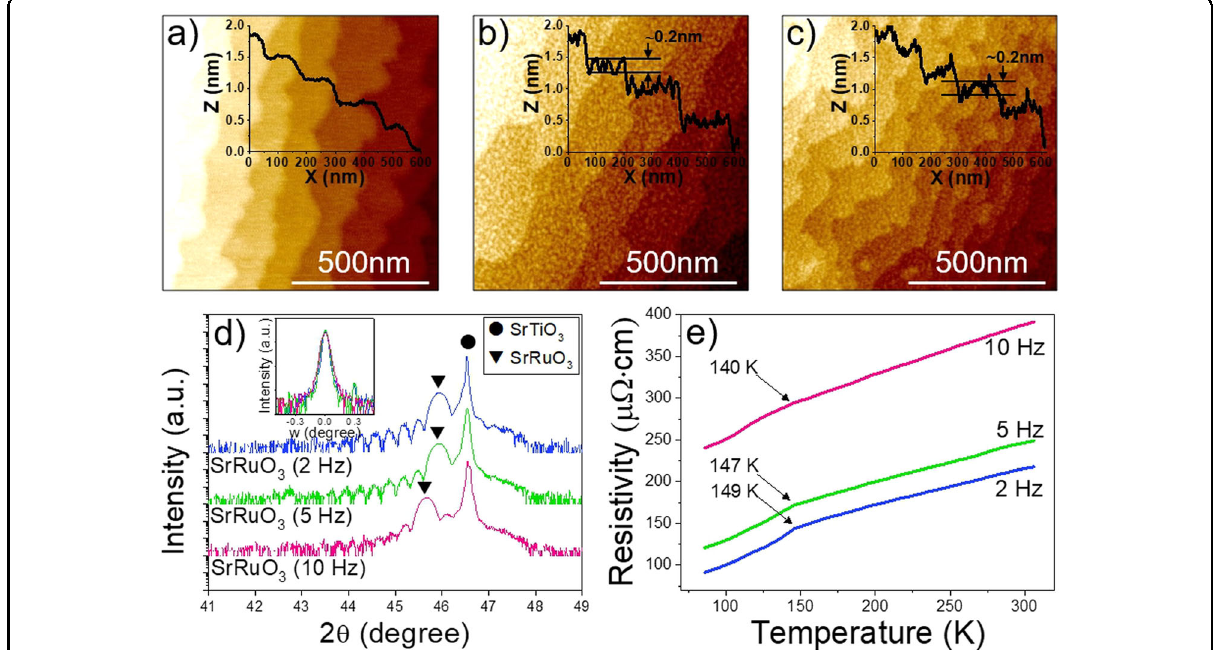
Fig. 1 Structural characterization of the SrRuO3 bottom electrodes. AFM images of SrRuO 3 electrodes grown with laser repetition frequencies of a 2, b 5, and c 10 Hz. d XRD patterns of SrRuO 3 electrodes; the inset shows a rocking curve for the SrRuO 3 (200) peak. e Resistivity – temperature plots of the SrRuO 3